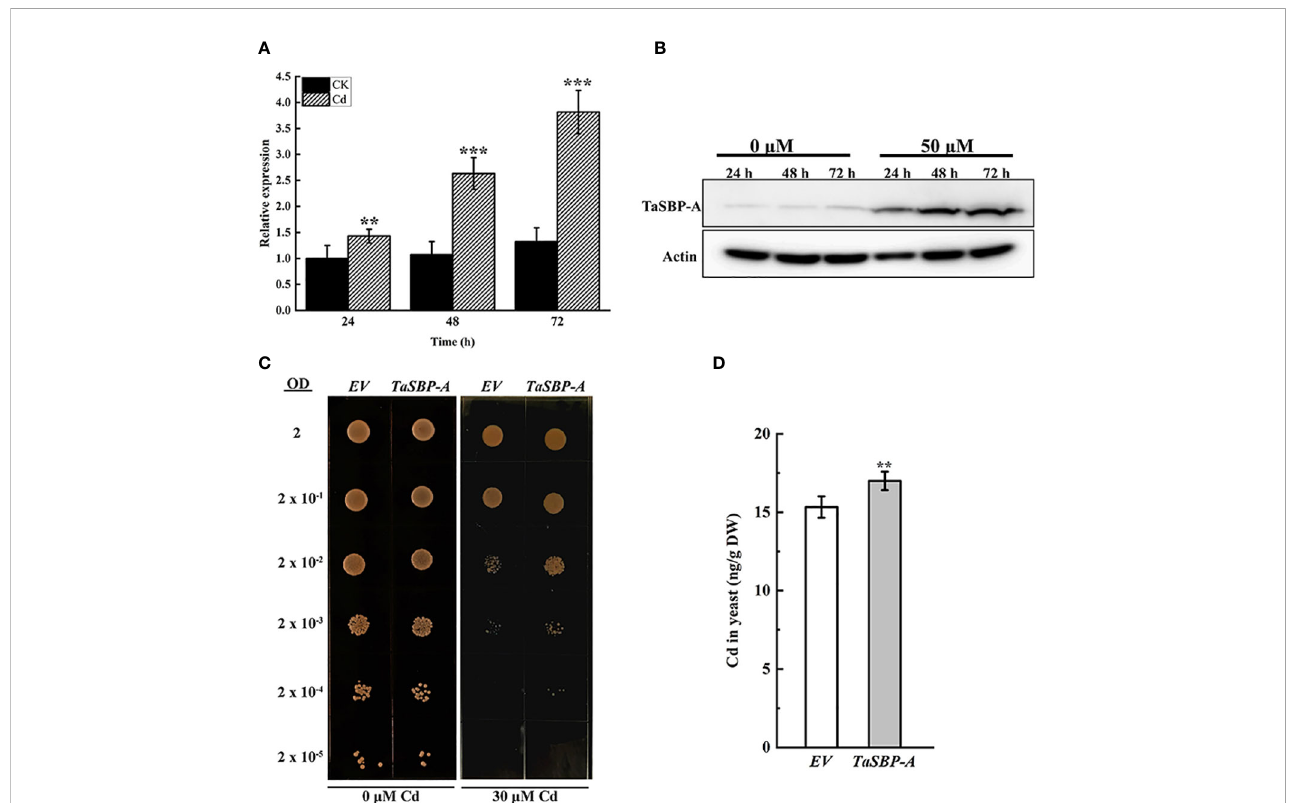
FIGURE 2 TaSBP-A responding to Cd-stress in Chinese Spring roots and its overexpression in Saccharomyces cerevisiae DEY1457. Wheat seedlings were treated with 50 m M CdCl 2 for 24, 48 and 72 h during the three-leaf stage. (A) Transcription expression by RT-qPCR. (B) Protein accumulation by Western blot. (C) Serial dilutions of the S. cerevisiae strains expressing the pYES2 empty vector (EV); a pYES2 harbouring one of the TaSBP-A spotted on medium supplemented with 0 (control) or 30 m M CdCl 2 , as indicated at bottom of the panels. Each spot is comprised by 5 m l of a yeast culture diluted at the optical density at 600 nm (OD600 = 2.0 is the fi rst spot). (D) Cd content of harvested cells measured by ICP-MS. A one-way ANOVA was used for the statistical analysis of the data. The asterisks represent the signi fi cant differences at different levels (** p <0.01; *** p